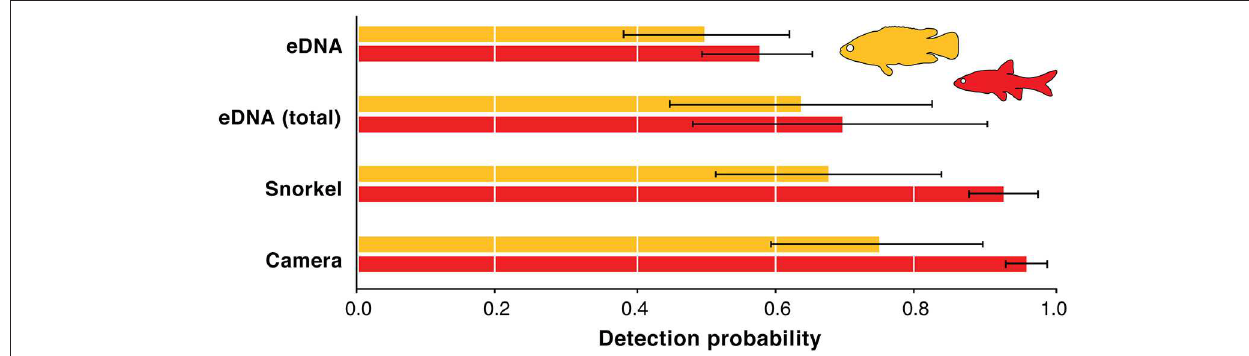
FIGURE 3 | Detection probability model-averaged estimates for underwater cameras, snorkel surveys, eDNA combined replicates, and eDNA replicates for redfins (red) and Cape Kurper (yellow). Error bars represent standard deviations.